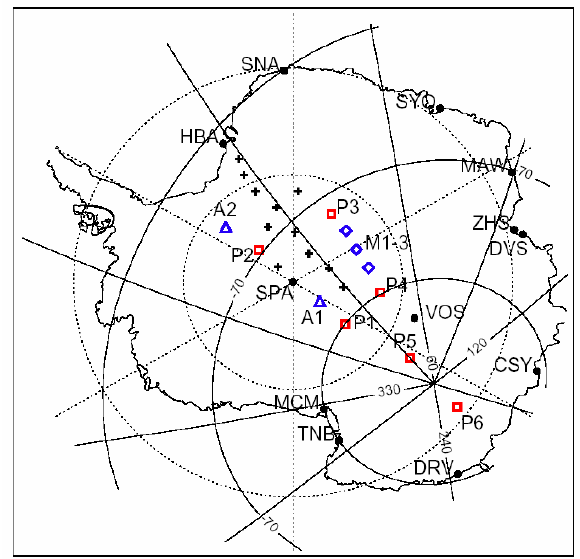
Fig. 1. Location of Zhongshan Station in Antarctic with geographic (geomagnetic) coordinates given by the dotted (solid) lines. Manned stations are shown by a three-letter international station name code. U.S. AGO/PENGUIN sites are shown by P#. British low-power magnetometers are shown by crosses. Proposed U.S. autonomous low power magnetometer (M1, M2, M3) sites are shown as blue diamonds and two proposed multi-instrument ARRO sites are marked as A1 and A2.